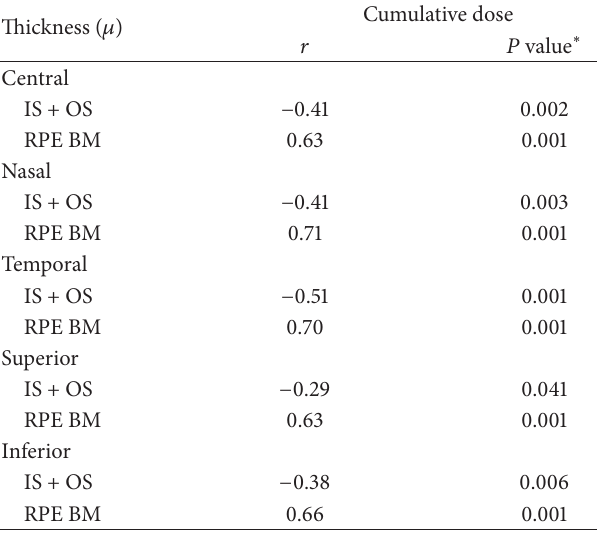
Table 6: Results of Pearson’s correlation analysis in users of hydroxychloroquine according to cumulative